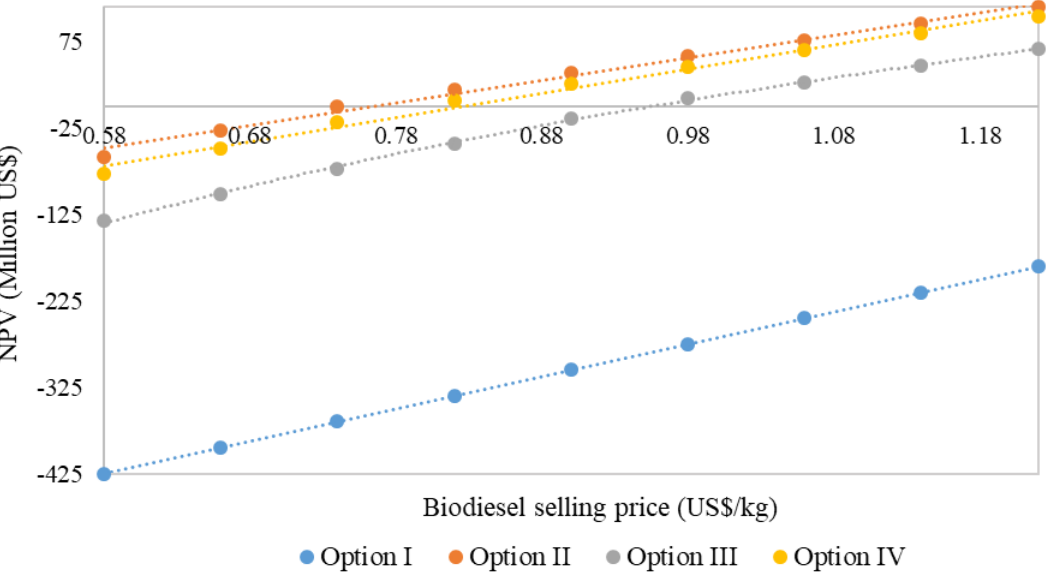
ff ect of change of biodiesel selling price on Figure 6. Effect of change of biodiesel selling price on NPV. Figure 6. E